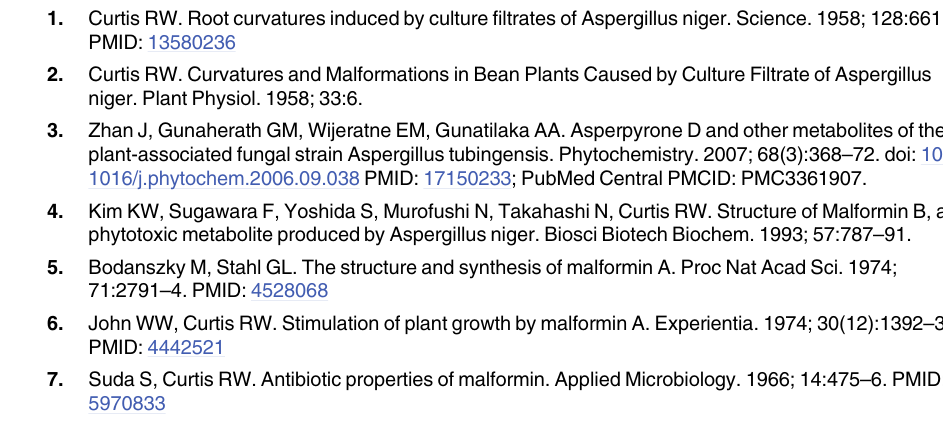
S1 Table. Growth inhibition of Malformin C for different cell lines. (PDF) S2 Table. Chemical panels of Malformin C treated BDF-1 mice.